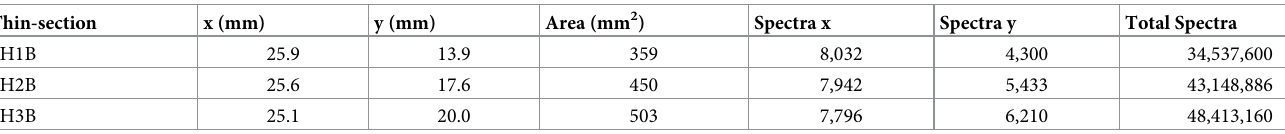
Table 3. Analysed area and number of spectra of hyperspectral SEM-EDS imaging datasets.